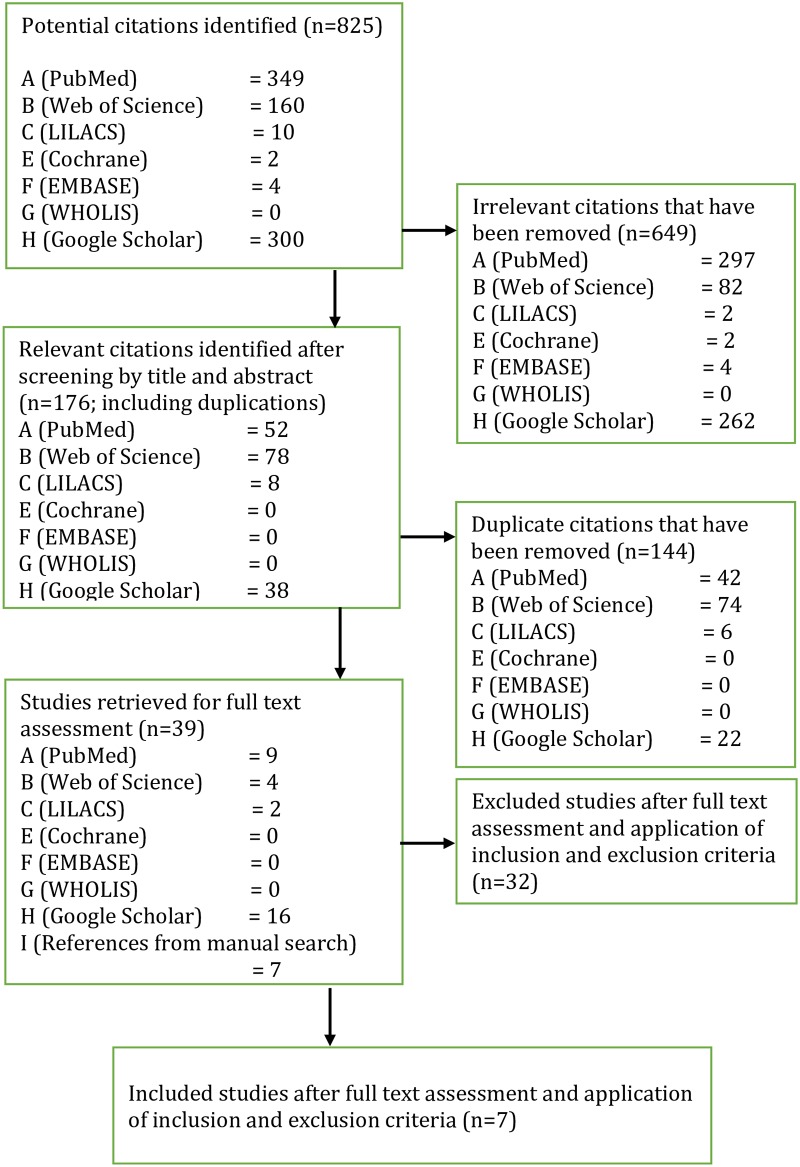
Flowchart of selection process.